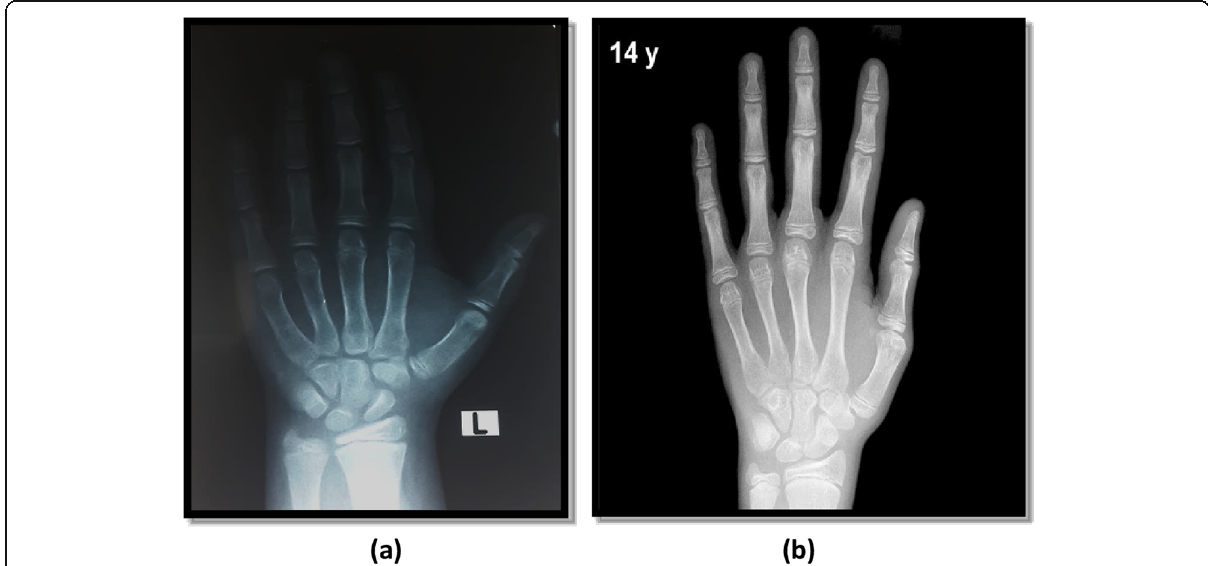
Fig. 2 a Radiograph of the left hand obtained in a 12.3-year-old Egyptian boy. b Greulich and Pyle method atlas image showing advanced